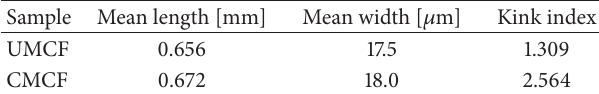
Table 1: The fiber quality analysis of UMCF and CMCF.